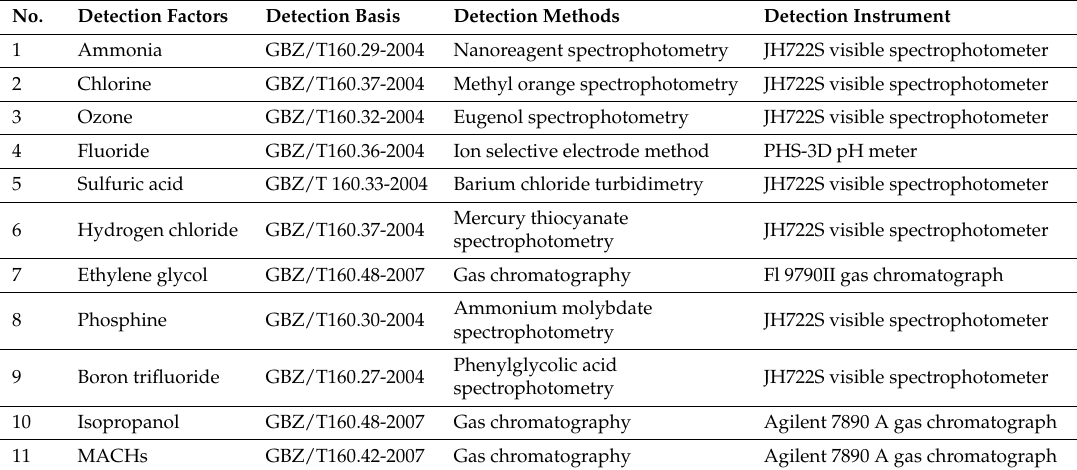
Table 2. On-site detection factors, basis, methods, instruments, and